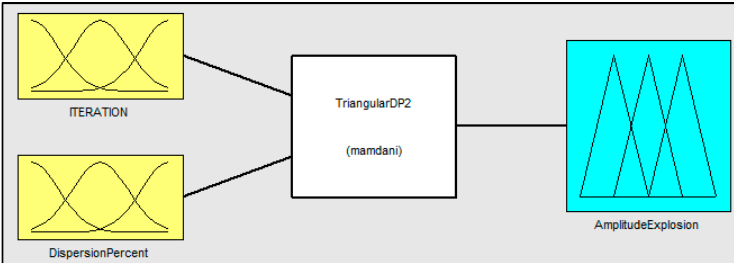
Figure 5. Graphical representation of the Fuzzy System for DPIFFWA-I.